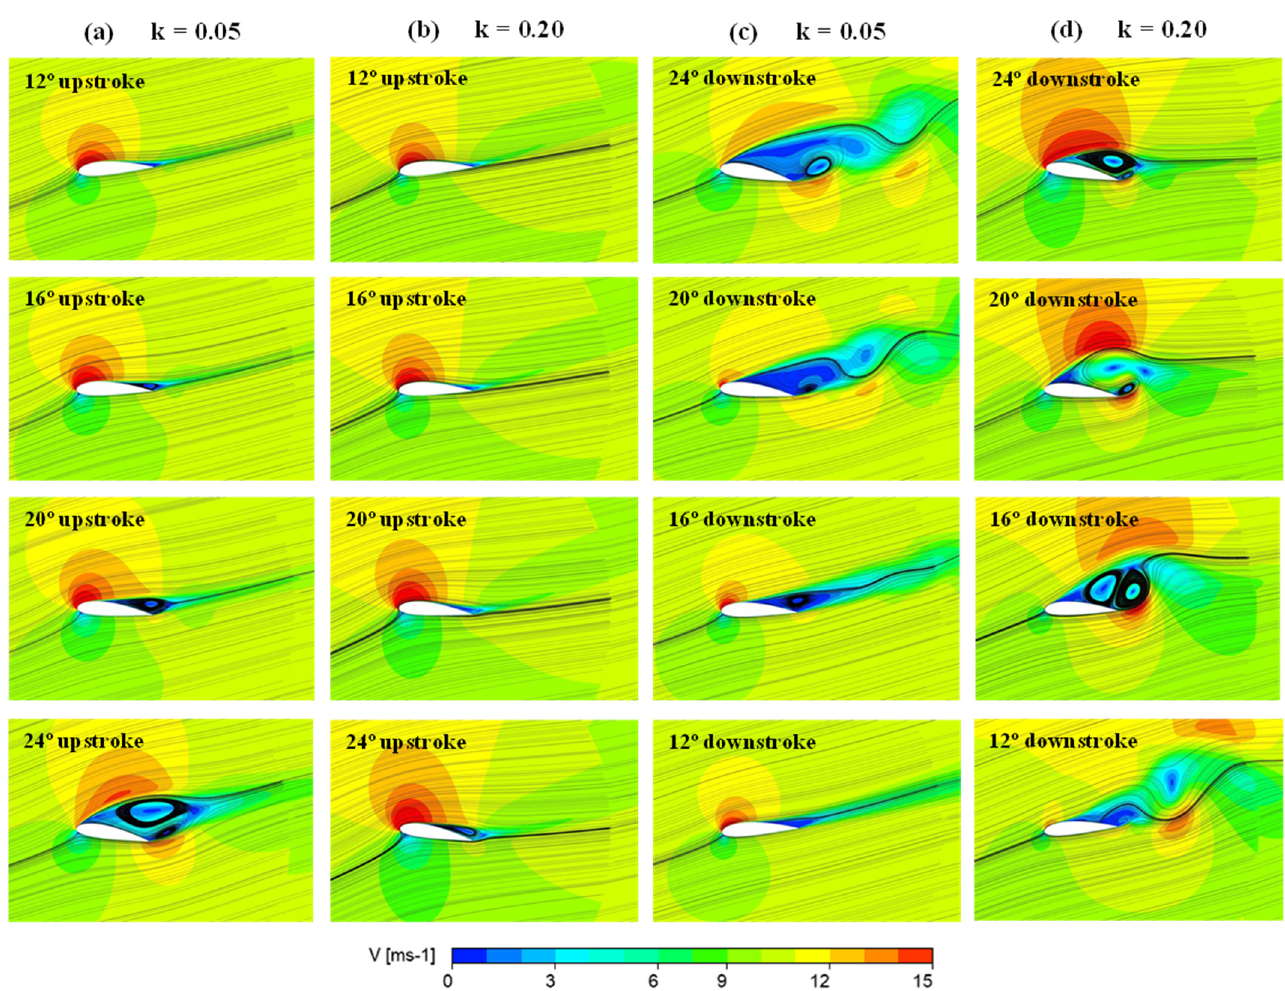
Figure 11. Velocity contours and streamlines at minimum k = 0.05 and maximum k = 0.20 during upstroke cycle ( a , b ) and downstroke cycle ( c , d ).